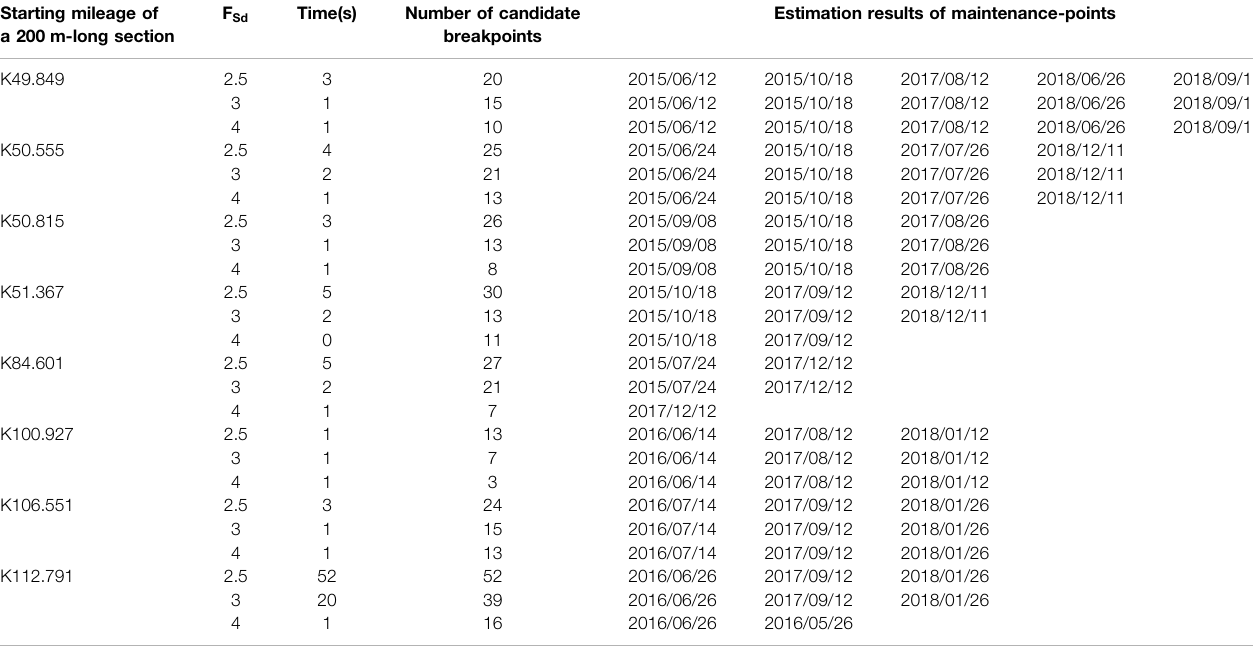
TABLE 4 | The comparison results among different values of F Sd . Starting mileage of a 200 m-long